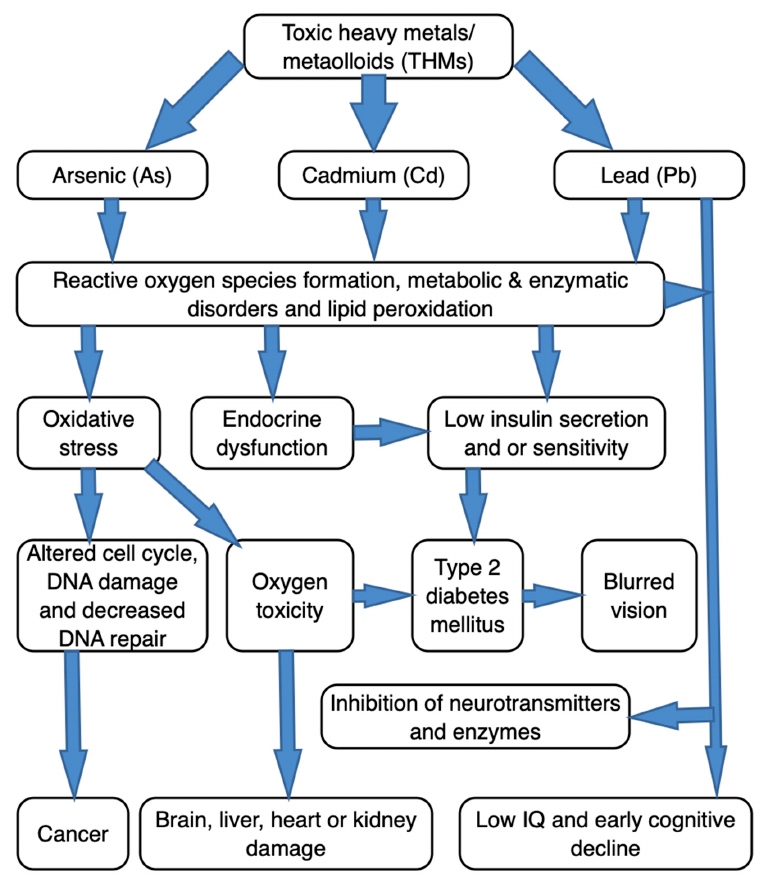
Figure 1. A schematic diagram depicting the complexities associated with toxic heavy metals (also ‘metalloids’), arsenic, cadmium and lead, in the pathogenesis and progression of certain disease conditions of public health